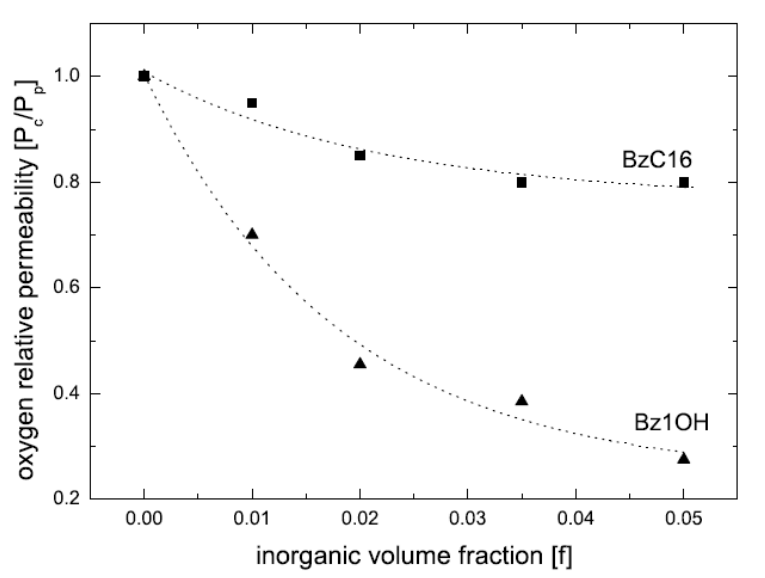
Figure 40. Oxygen permeation of the epoxy nanocomposites as a function of filler volume fraction. Reproduced from reference [45] with permission from The American Chemical